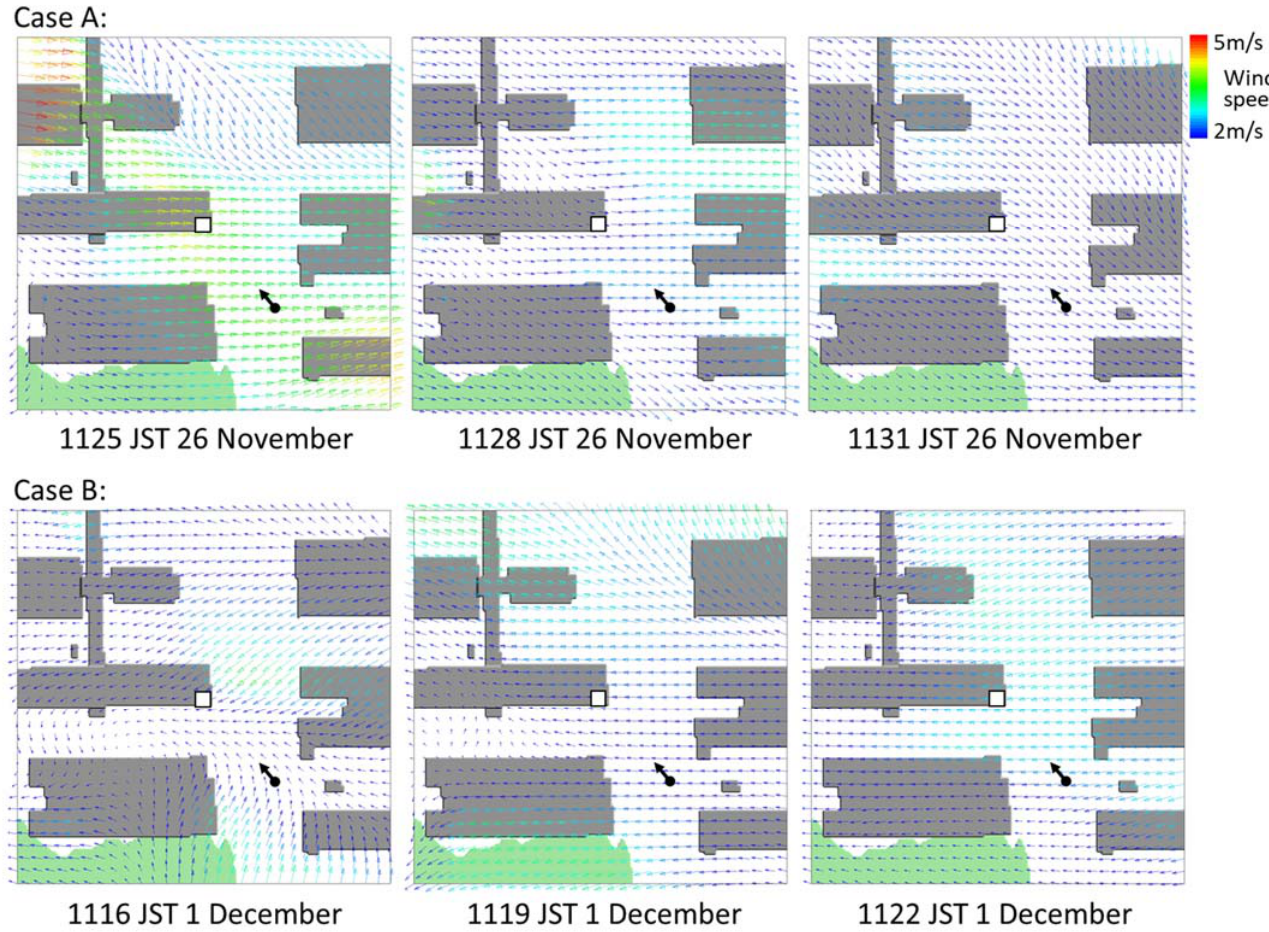
Figure 8. Horizontal distributions of the Doppler LiDAR-derived wind velocity vectors near the mist plume release height. The areas correspond to the square area of 150 m × 150 m shown in Figure 1. The white square depicts a position of the mist-spraying system placed at the building rooftop. The arrow indicates a position of the digital camera on the ground directed toward the mist-spraying system. The case A is the period from 1125 to 1131 JST 26 November. The case B is the period from 1116 to 1122 JST 1 December.